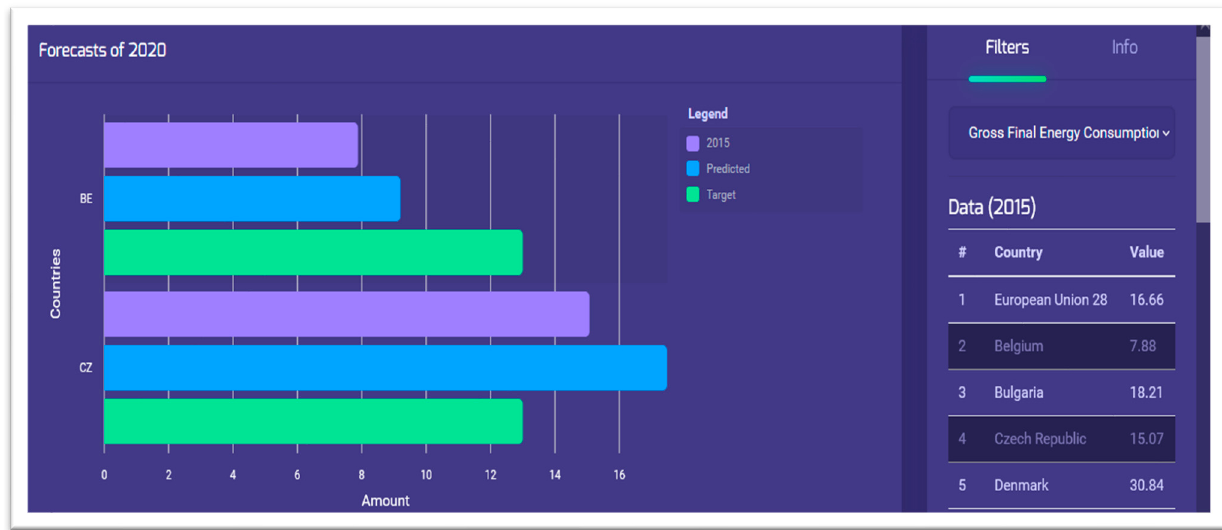
Figure 4. Comparison bar chart of Gross Final Energy Consumption of two EU countries. The line chart is a time series chart of a selected indicator for one or more EU countries. In this chart, there is the capability to show the predictions along with the confidence intervals until 2020 (Figure 5).